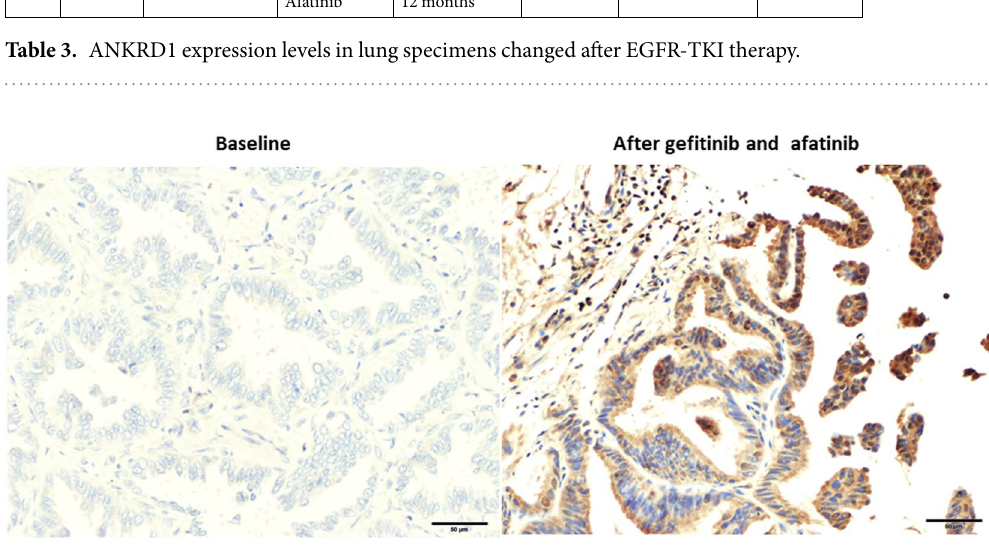
Figure 4. IHC staining for ANKRD1 in lung cancer specimens obtained from patient No.9. Negative ANKRD1 staining before EGFR-TKIs treatment (left), and positive ANKRD1 staining after gefitinib and afatinib therapy